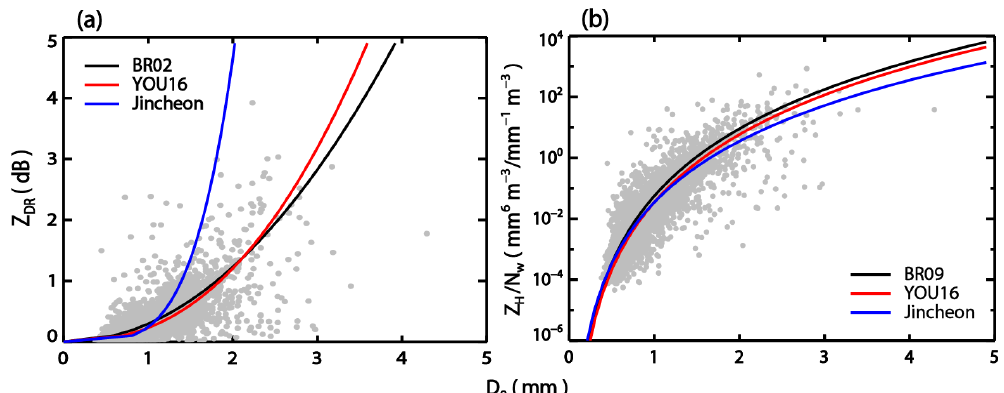
Figure 10. Scatter plots of ( a ) the retrieved Z DR (dB) against D 0 (mm) and ( b ) retrieved Z H / N w (mm 6 m − 3 /mm − 1 m − 3 ) versus D 0 (mm), with curves fitted from BR02 and BR09 (black), YOU16 (red), and to the Jincheon: BR03-VPR data